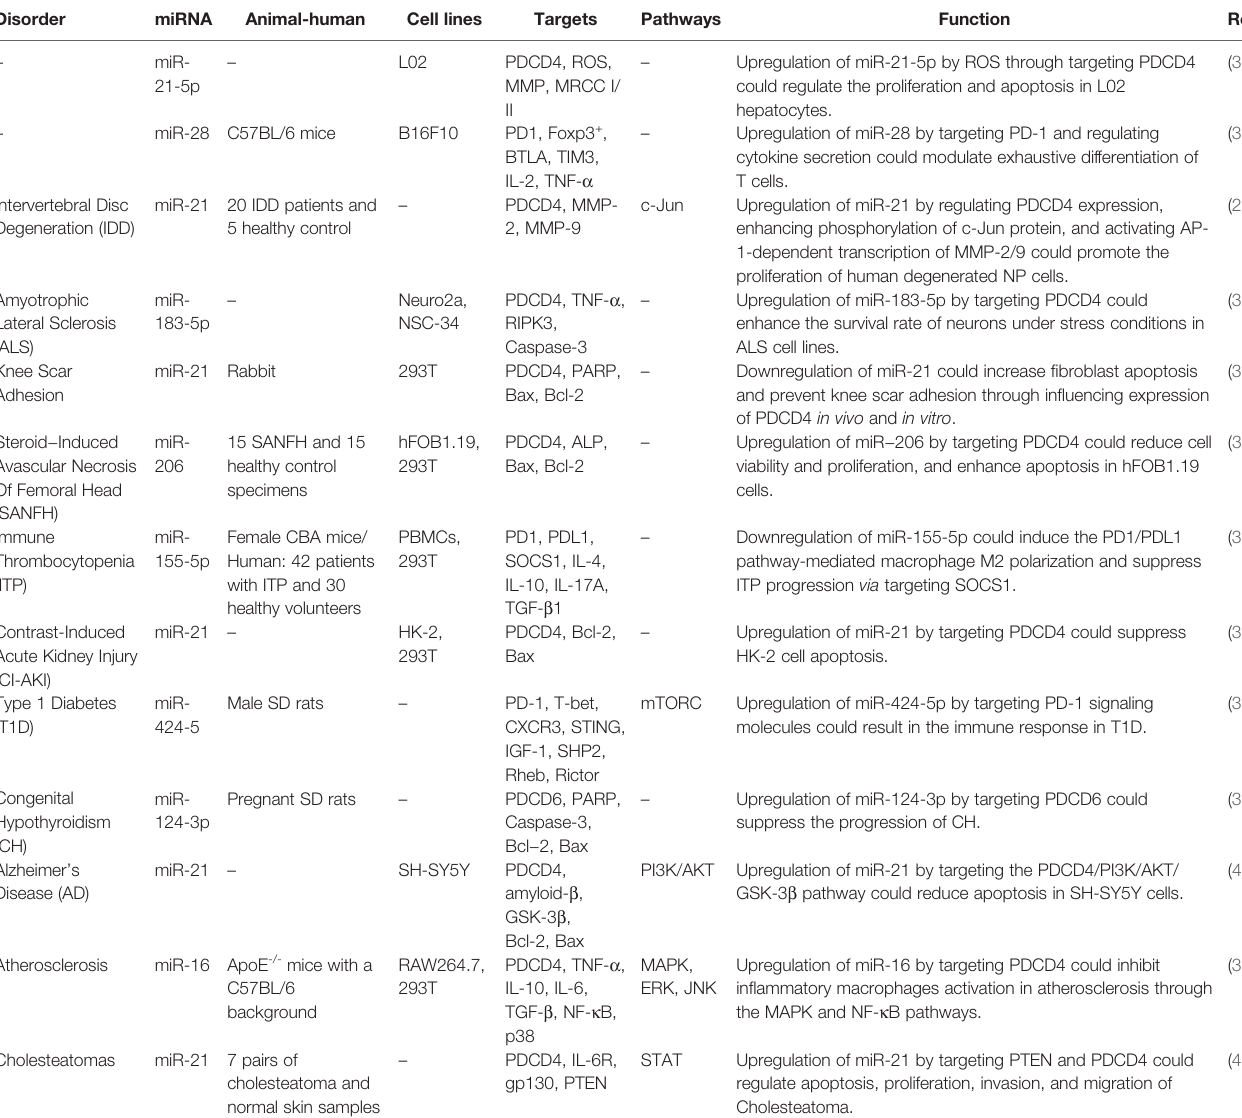
TABLE 3 | Interaction between miRNAs and PDCD in other non-neoplastic